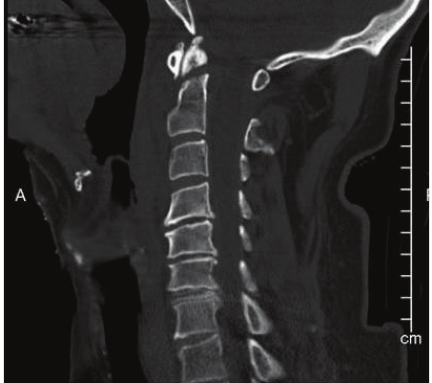
Figure 3: Midaxial sagittal cervical spine CT showing a slightly distracted Type II dens fracture without additional cervical spine